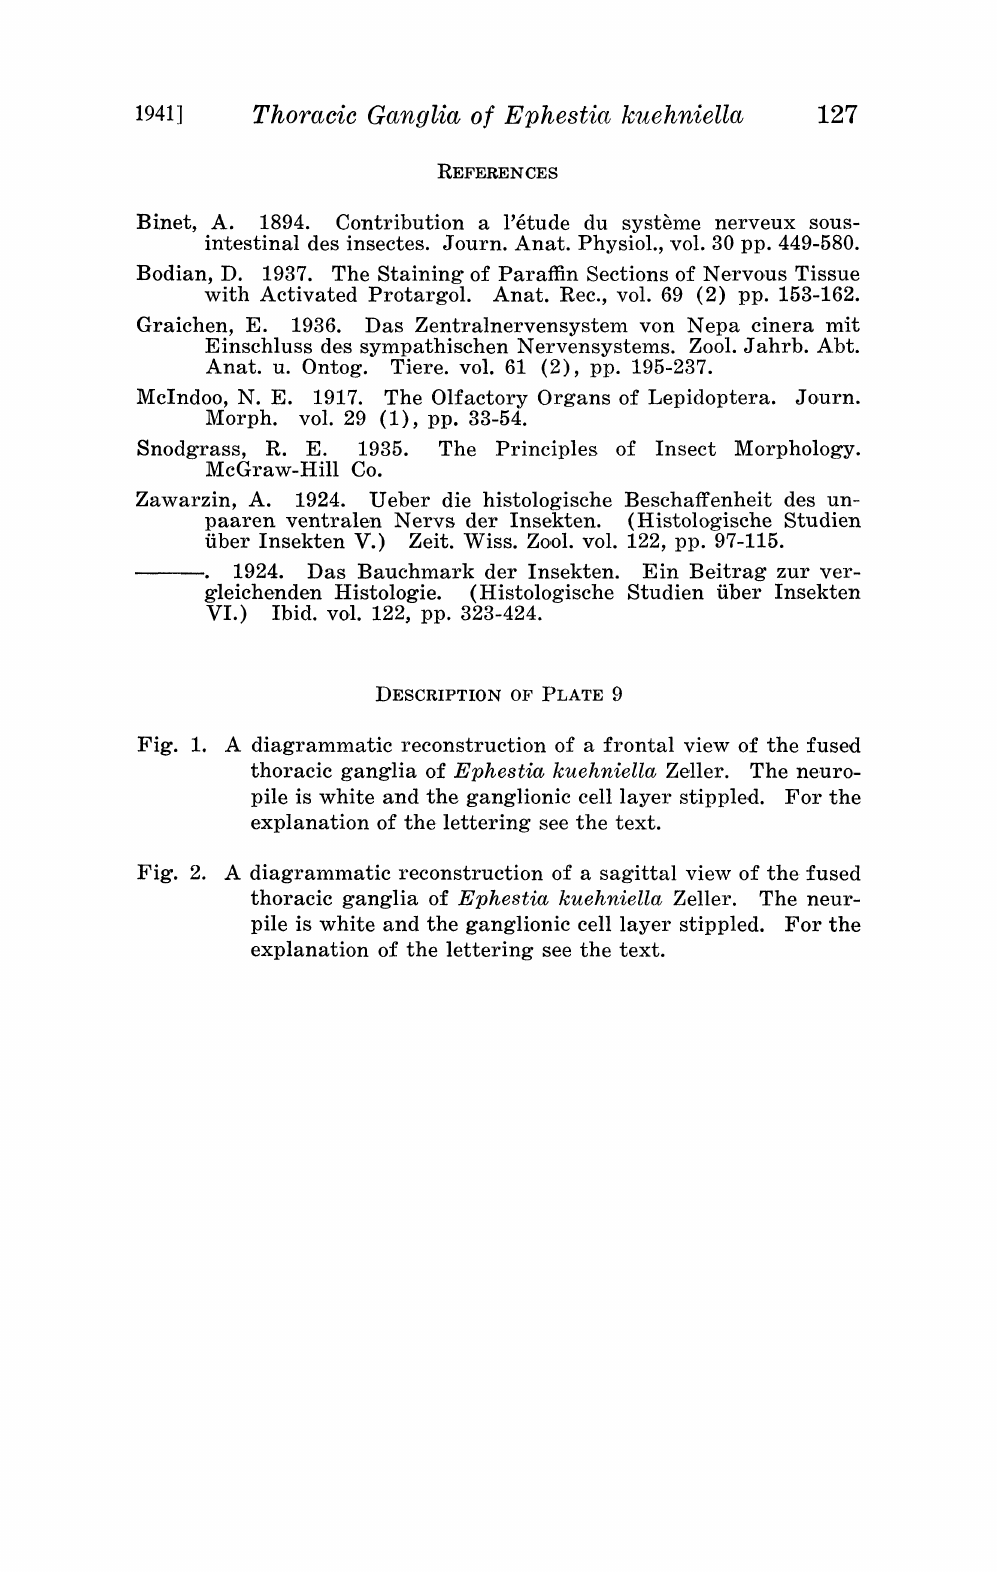
Fig. 1. A diagrammatic reconstruction of a frontal view of the fused thoracic ganglia of Ephestia kuehniella Zeller. The neuro- pile is white and the ganglionic cell layer stippled. For the explanation of the, lettering see the text,. Fig. 2. A diagrammatic reconstruction of a sagittal view of the, fused thoracic ganglia of Ephestia kuehniella Zeller. The neur- pile is white and the ganglionic cell layer stippled. For the explanation of the lettering see the